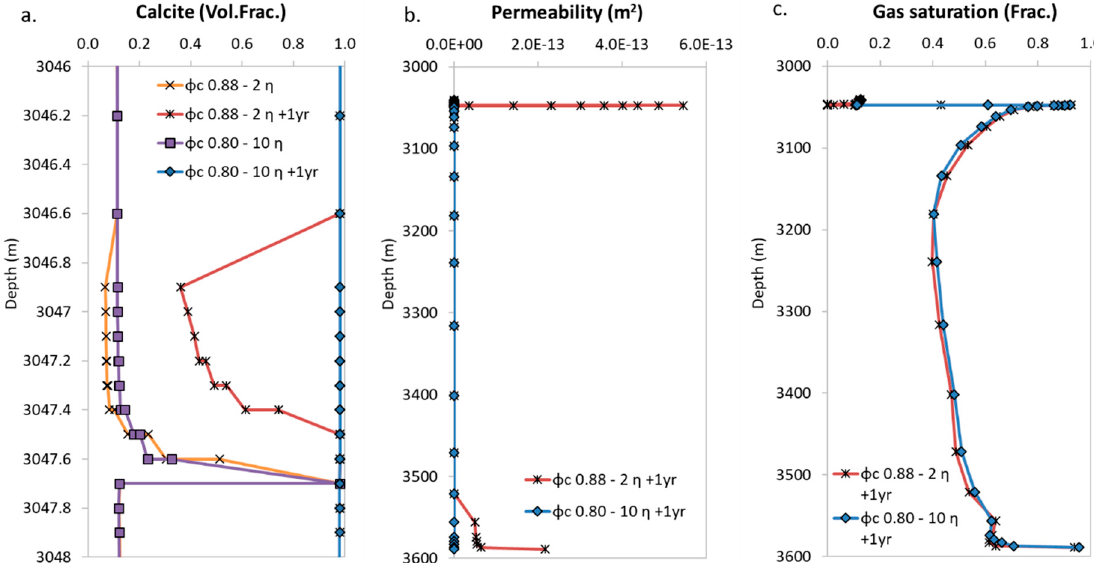
Figure 8. The development of the microannulus within 1 year after remediation. Results are shown for ( a ) calcite around the original plug, ( b ) permeability of the microannulus, and ( c ) gas saturation of the microannulus adjacent to the caprock.